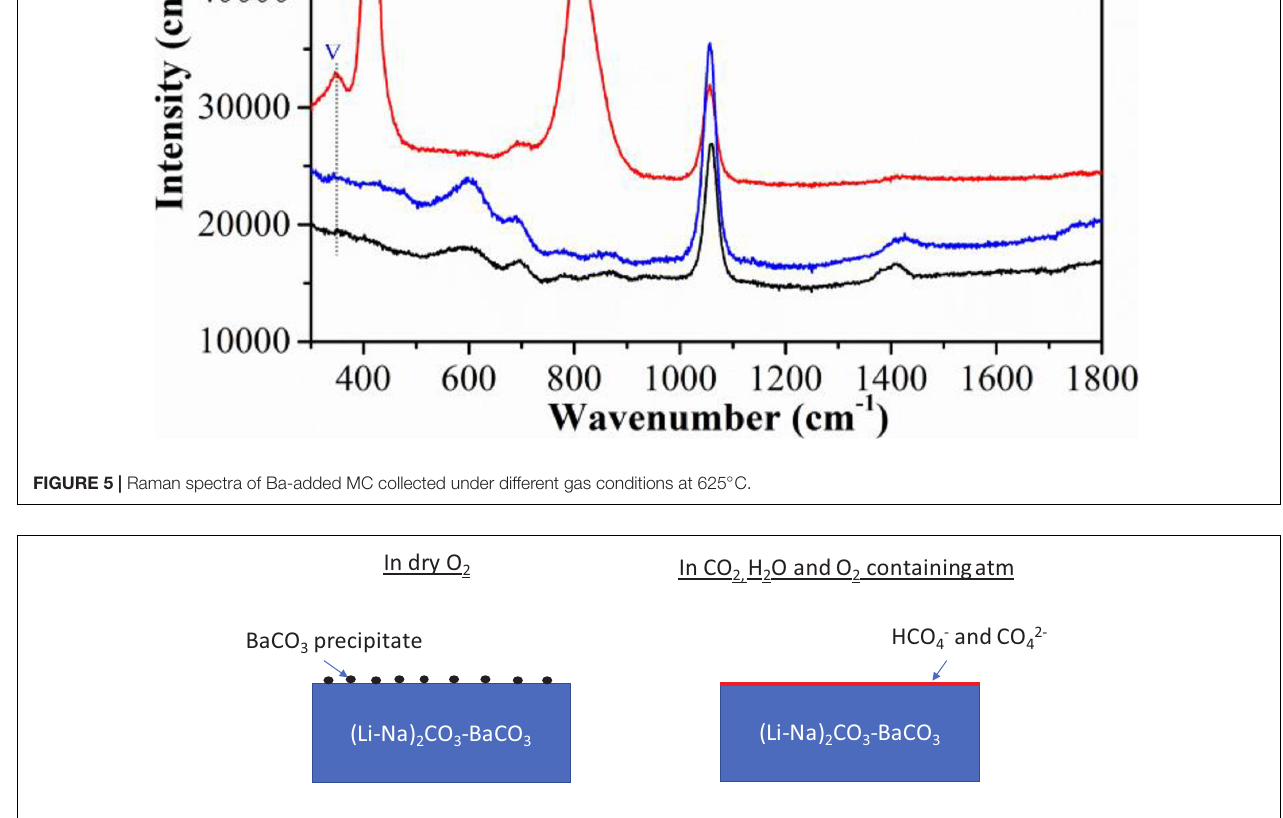
FIGURE 6 | Surface species of Ba-added MC exposed to different gas